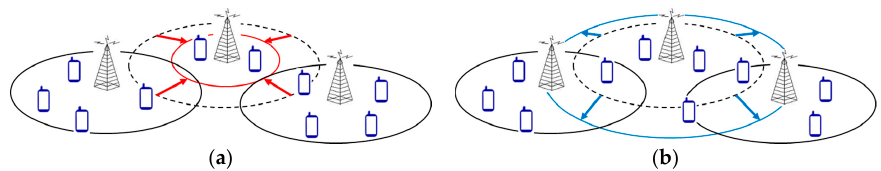
Figure 2. Operation of cell zooming: ( a ) zooming-in; ( b ) zooming-out.